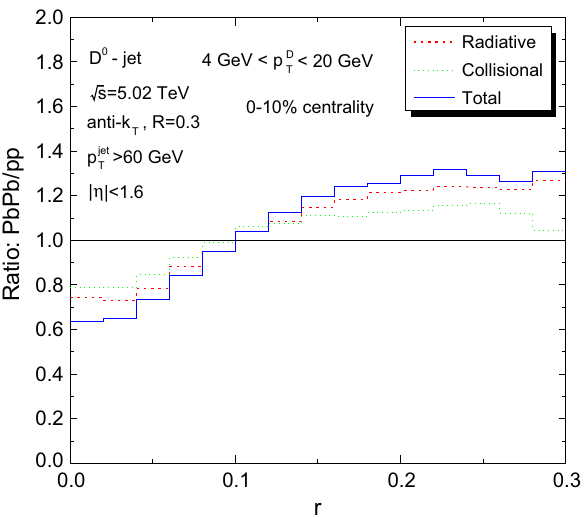
Fig. 5 The ratio of D 0 meson radial distribution in jets of 0 − 10% Pb + Pb to p + p, when only collisional interaction considered (green dotted line), only radiative process considered (red dashed line), and both of them considered (blue line) for charm quarks